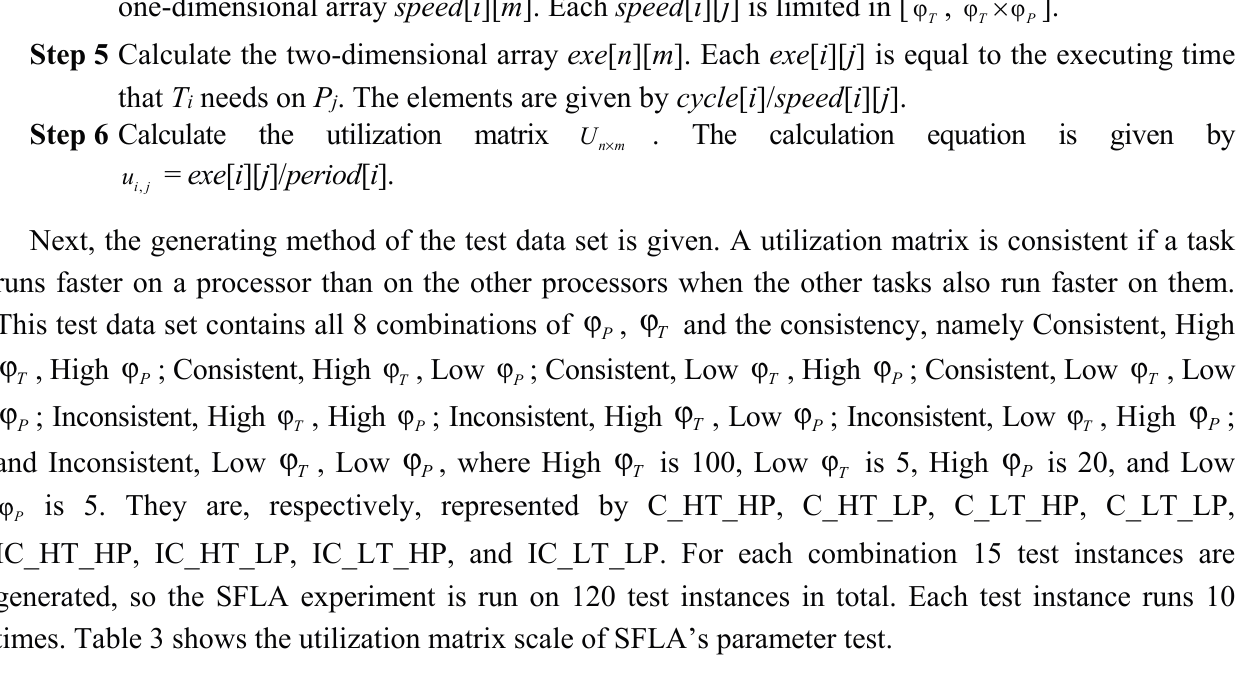
Table 3. The utilization matrix scale of SFLA’s parameter